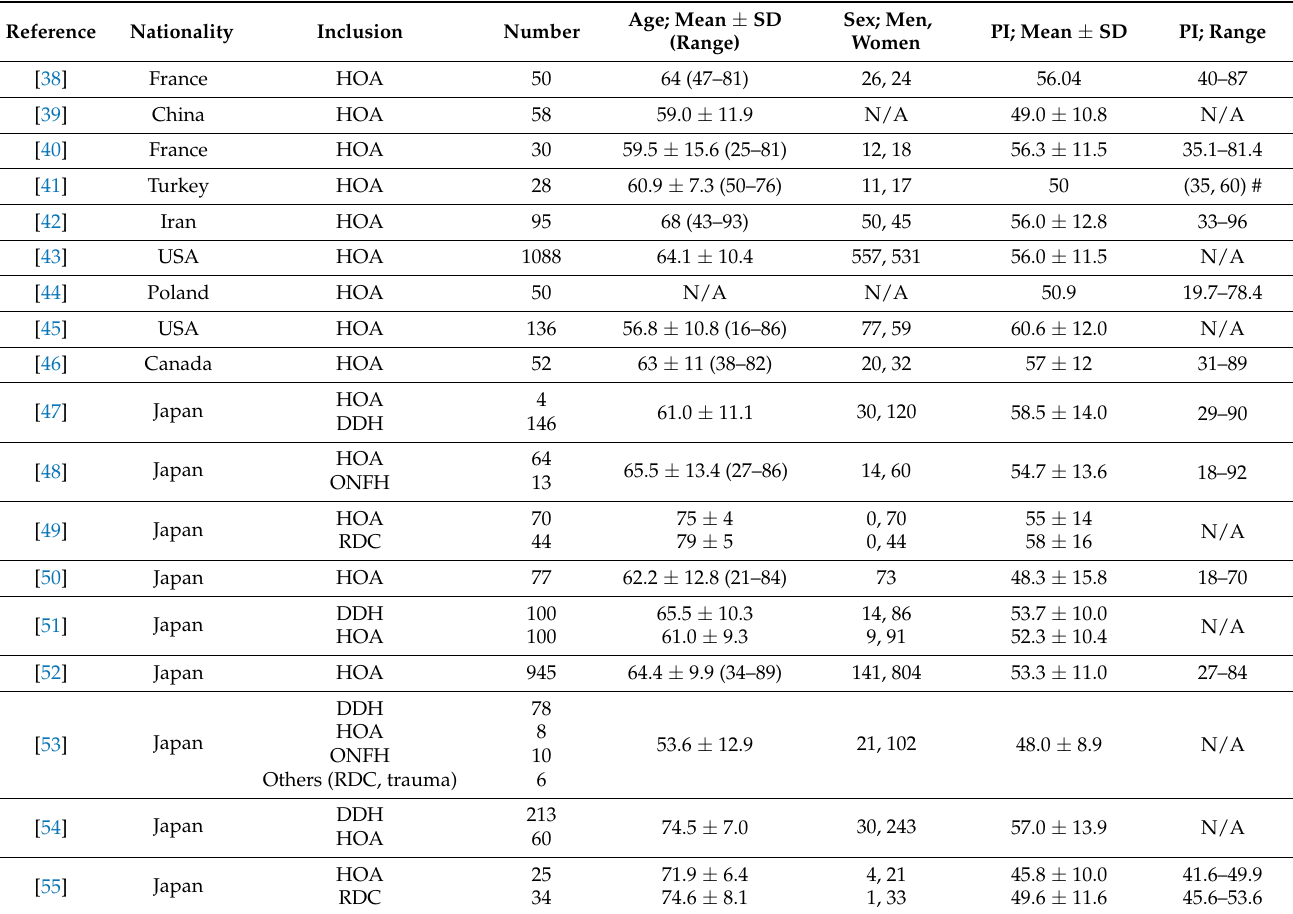
Table 1. Summary of the